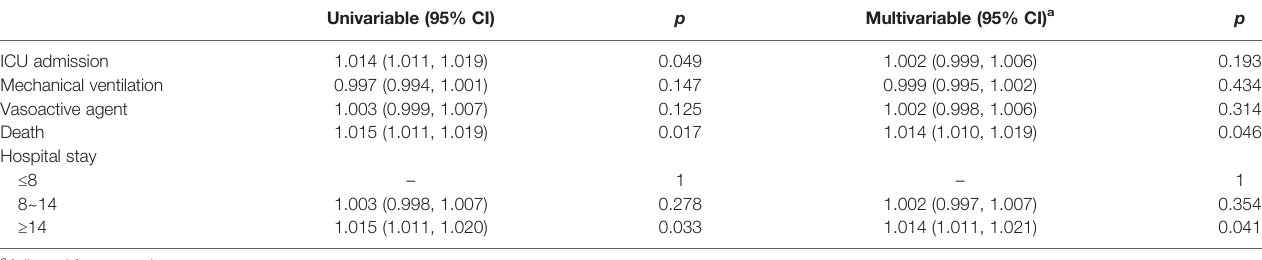
TABLE 4 | Association between serum S100A12 and prognosis in CAP